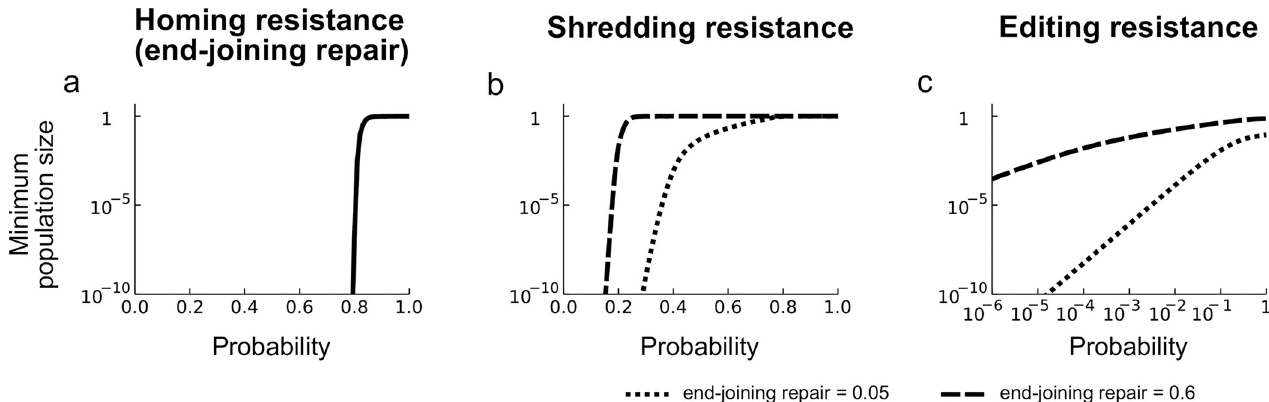
Fig 3. The impact of target site resistance. Minimum population size (relative to the pre-release equilibrium) as a function of the probability of a resistant allele forming at the site of homing (a), shredding (b), and editing (c; note log X-axis). For (b) and (c) results are shown for both low and high EJR scenarios (5% and 60% EJR,